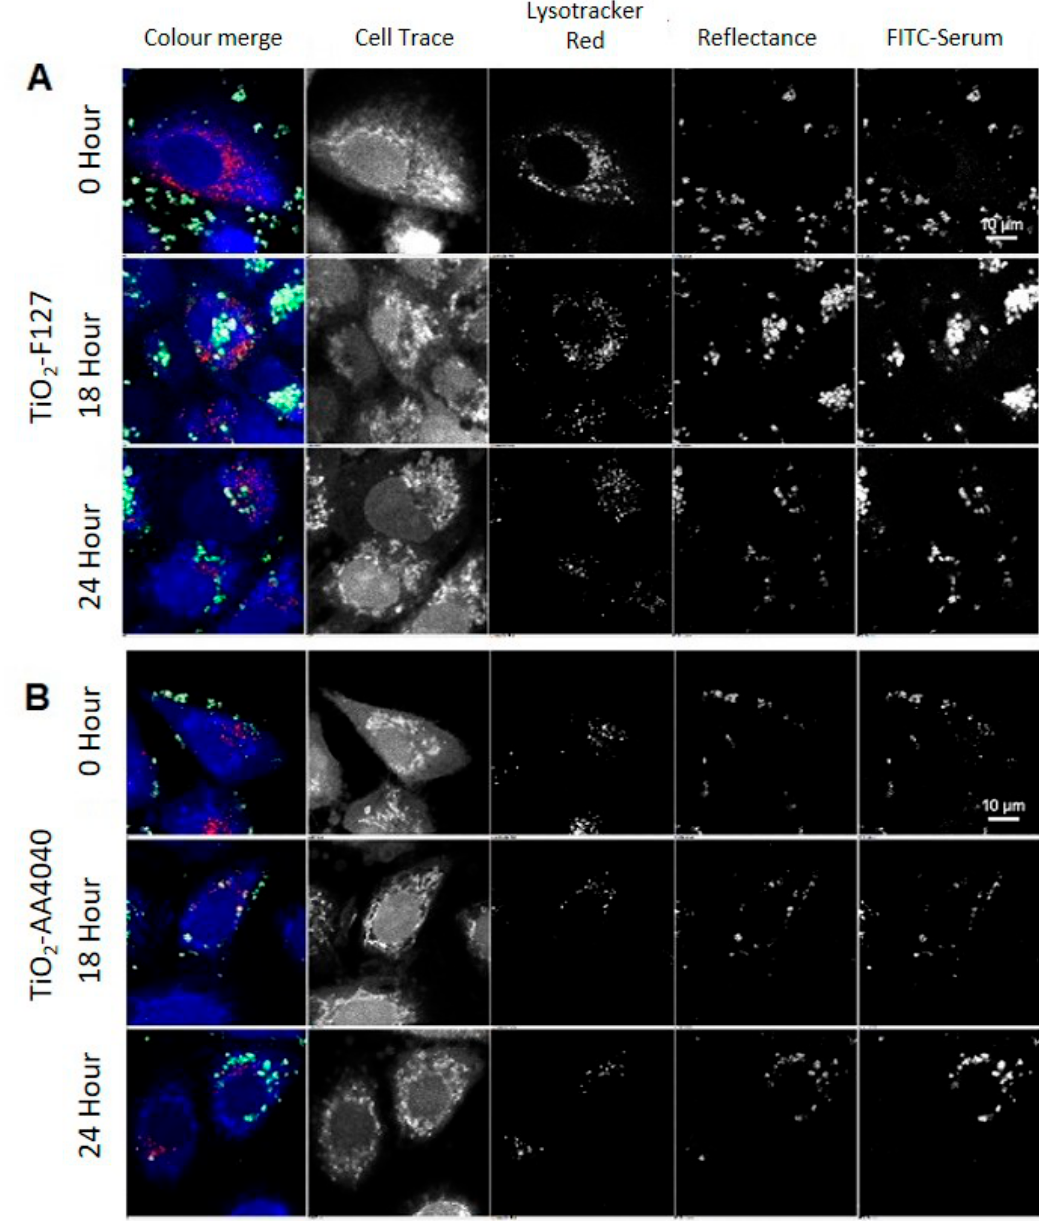
Figure 4. Confocal acquisition of A549 cells treated with ( A ) Pluronic-F127 (TiO 2 -F127) and ( B ) Dispex-AA4040 (TiO 2 -AA4040)-coated TiO 2 NMs and compared to the control (untreated cells) in FITC-labeled serum, followed by post-acquisition in unlabeled serum and fixation at 15 min (0 h), 2, 6, 18, and 24 h post-exposure. Compared to TiO 2 -un- and TiO 2 -PVP-coated NMs (Figure 3), these show significantly larger agglomerates which accumulate on the cell surface, and have been taken up into the cells by the 18 h time point, beyond which they appear to be retained.